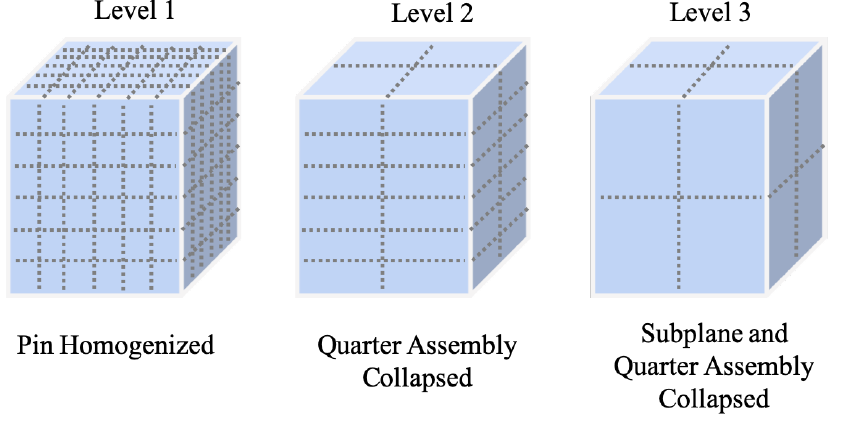
Figure 1. Spatial collapse for MLS